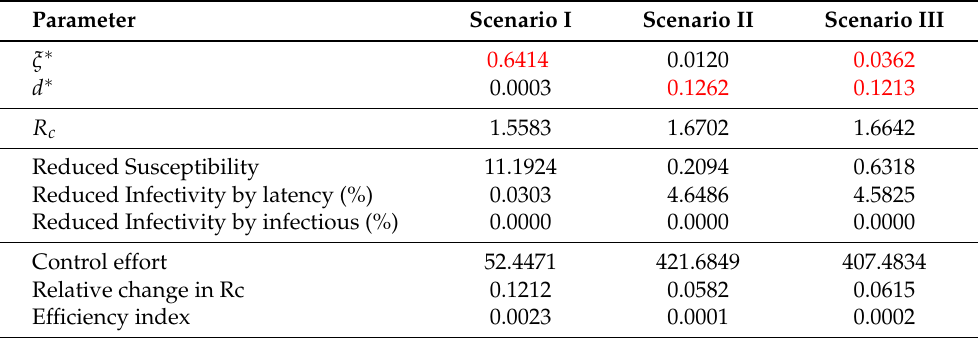
Table 4. Improvement of quarantine measure by increasing testing rate and the effectiveness of quarantine based on the parameters estimated in the second phase of the second